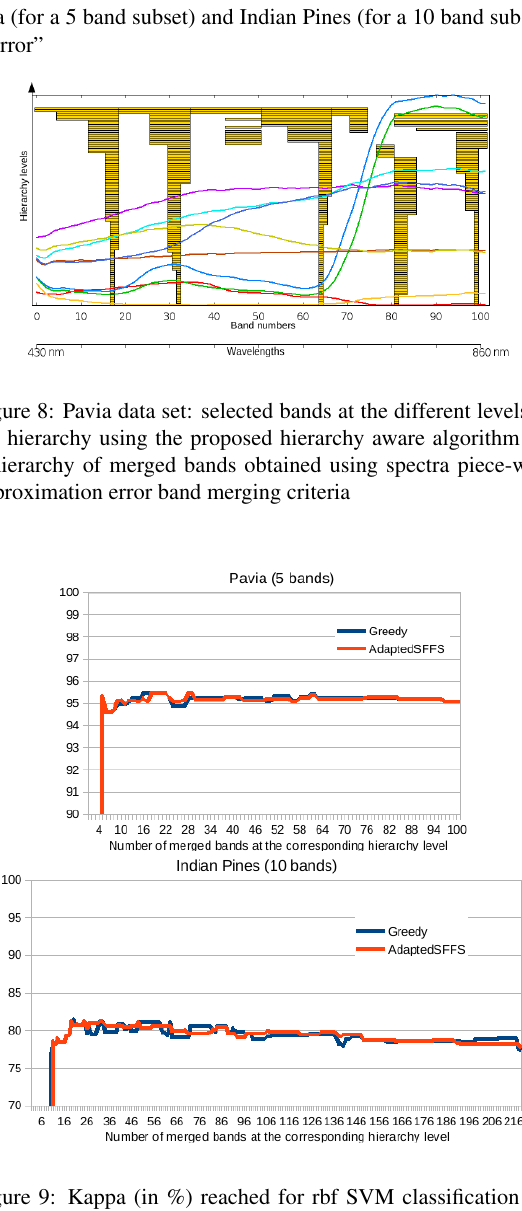
Figure 9: Kappa (in %) reached for rbf SVM classification for merged band subsets selected at the different levels of the hier- archy (built for band merging criterion “spectra piece-wise ap- proximation error”) for Pavia and Indian Pines data sets, using the hierarchy aware band selection